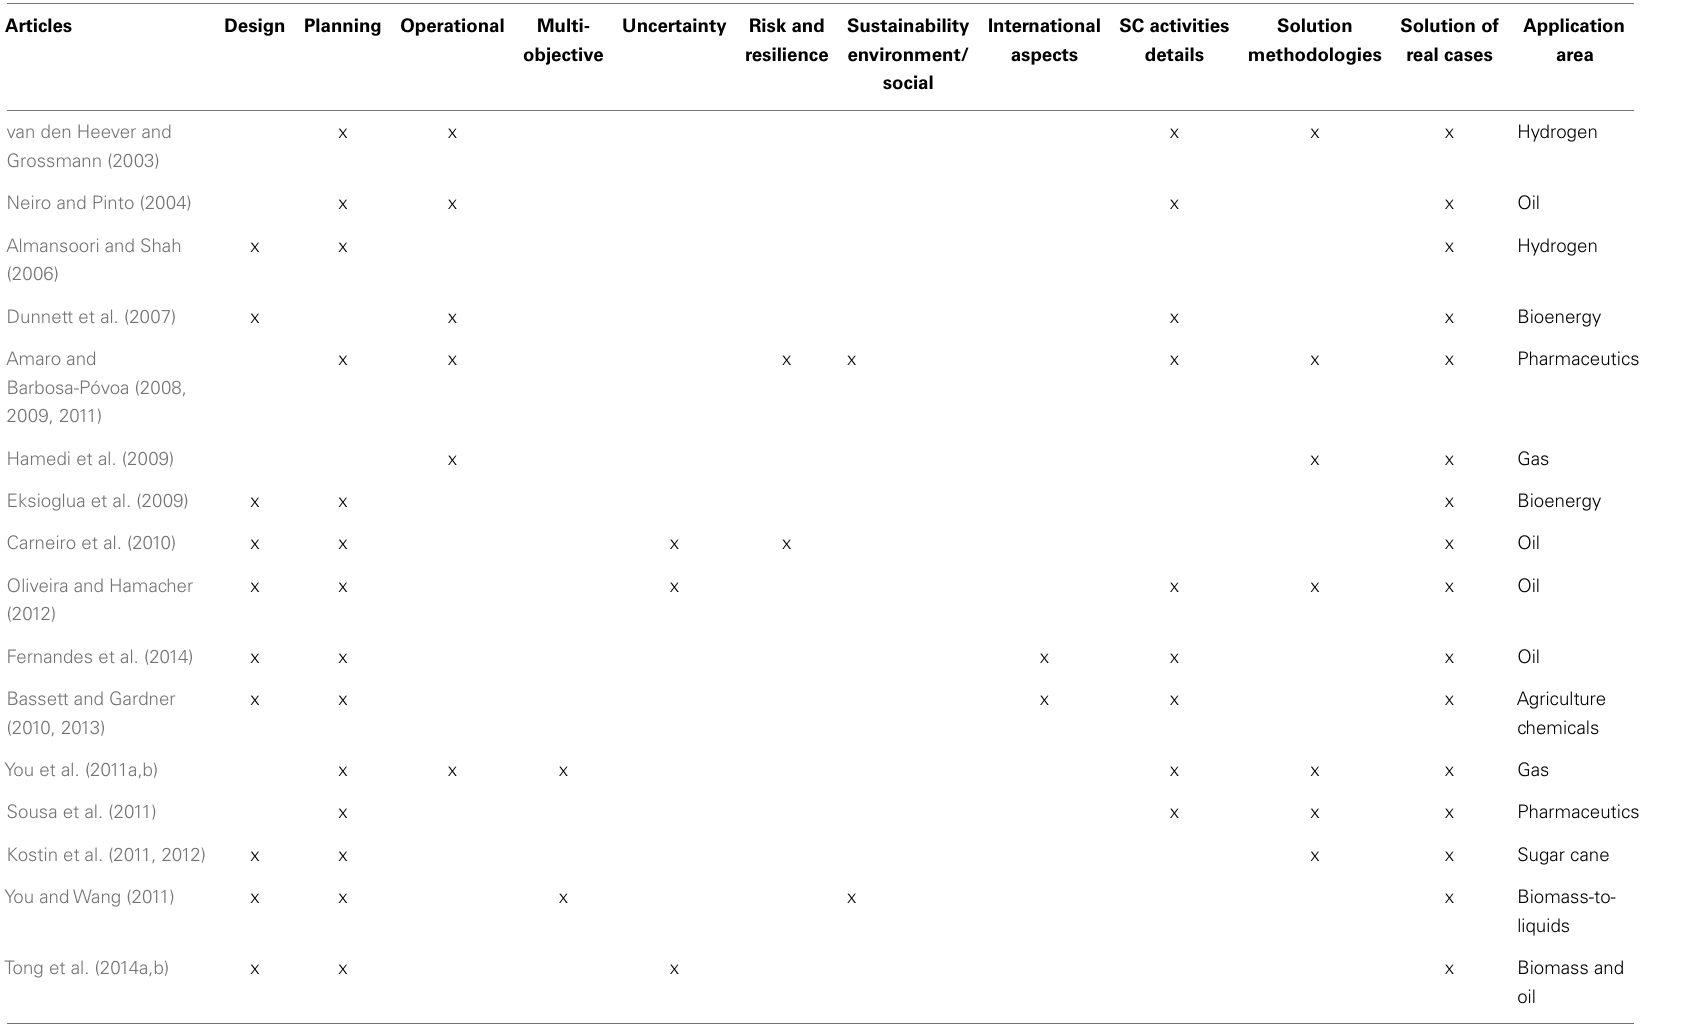
Table 4 | Main supply chain real applications